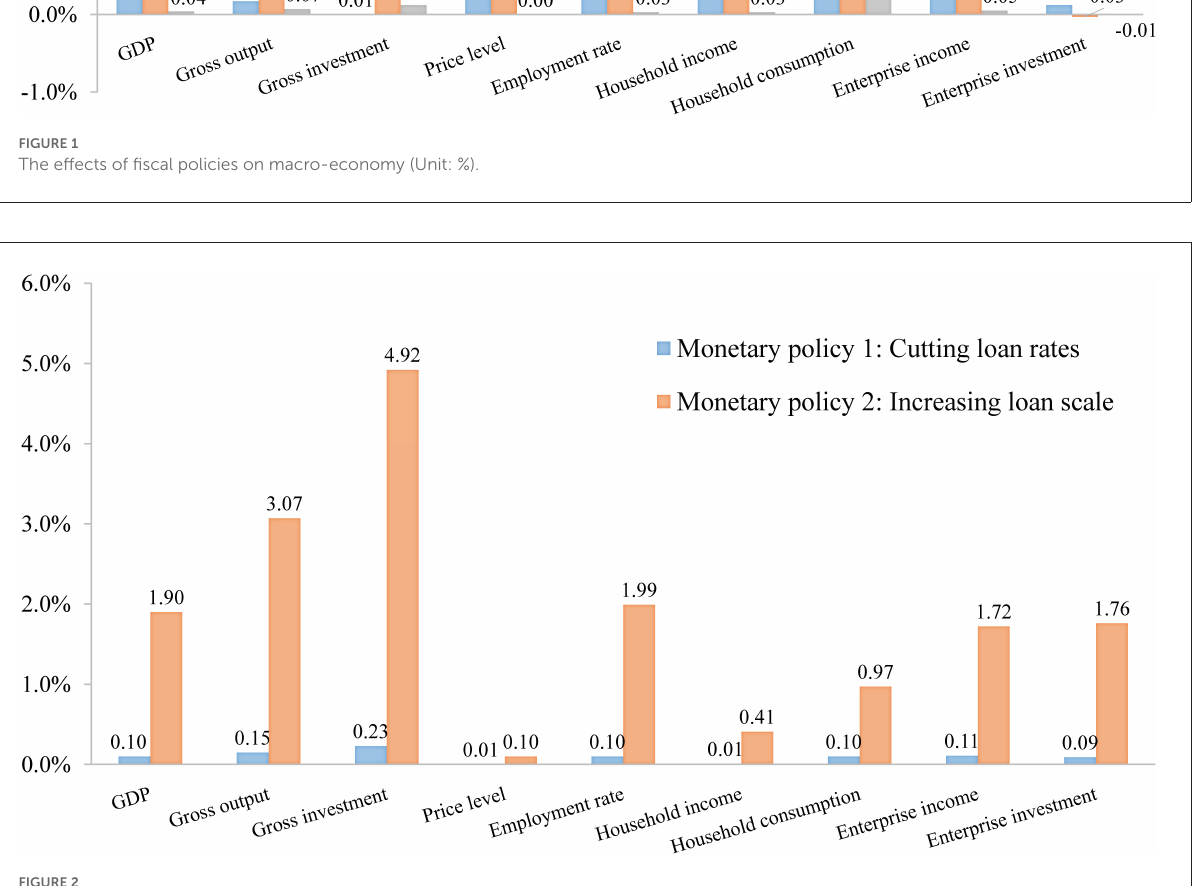
FIGURE2 The effects of monetary policies on macro-economy (Unit: %).